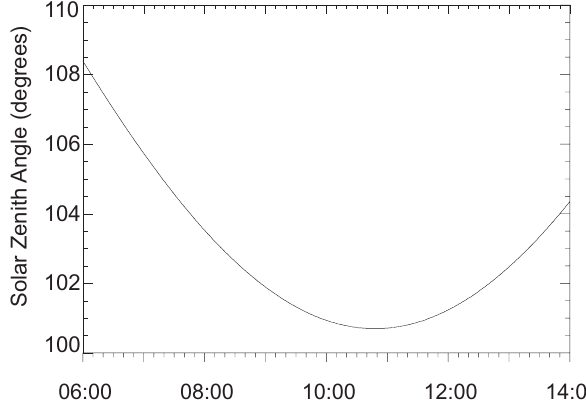
Fig. 4. The variation of solar zenith angle with UT at Longyearbyen during the red sky event. The lowest solar zenith angle is 100.7 ◦ at 10:48